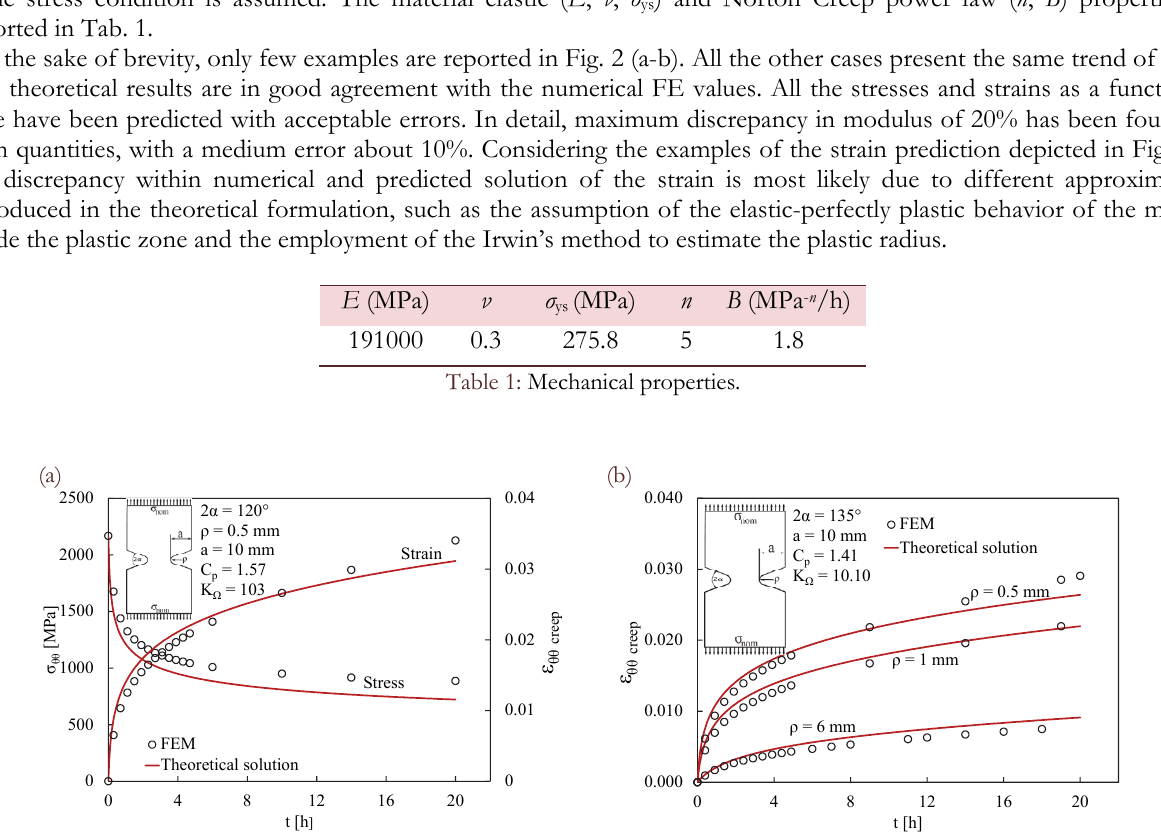
Figure 2: Comparison between theoretical and FEM evolution of stress and strain as a function of time for V-notch geometry: (a) ρ = 0.5 mm, 2 α = 120°; (b) 2 α = 135° and ρ = 0.5, 1, 6